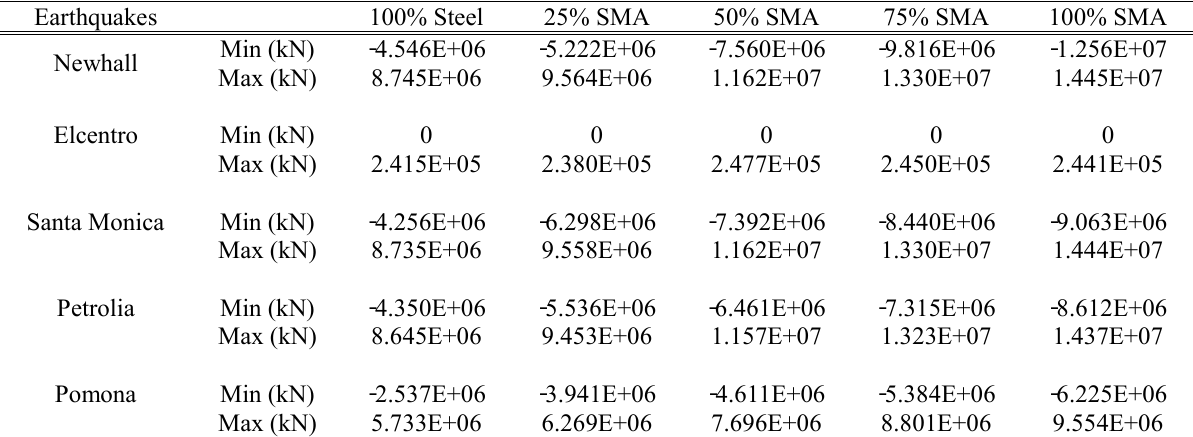
Minimum and Maximum Base Shears for Newhall Earthquake